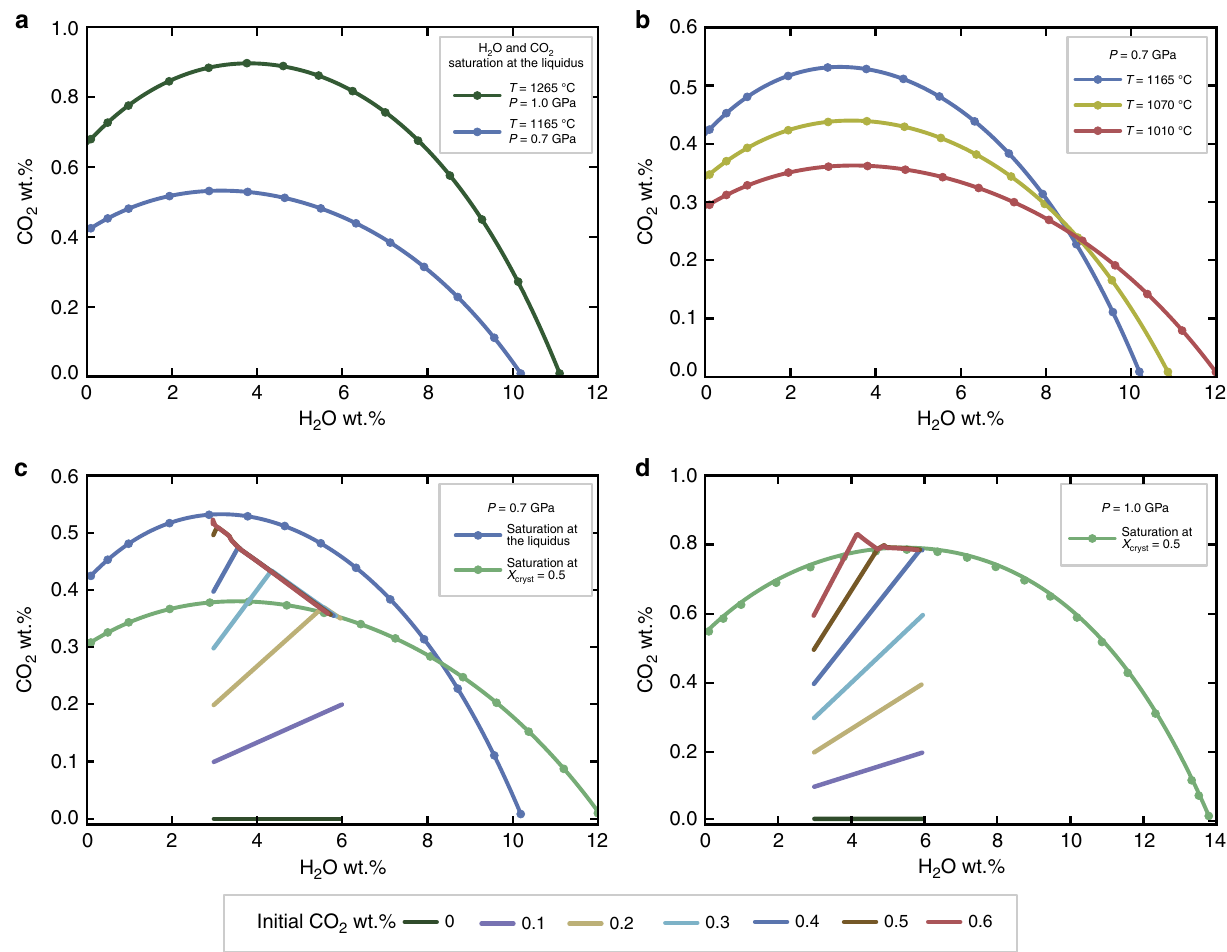
Fig. 1 Water and carbon dioxide solubilities in the melt phase. Solubility curves for water and carbon dioxide calculated for the mid-MgO system 30 : a Solubilities of the parental melt at pressures of 0.7 and 1.0 GPa and liquidus temperatures; b Solubilities of the residual melt during the crystallization process at a pressure of 0.7 GPa. The SiO 2 content in the residual melt on dry basis is 50.3, 50.9, and 57.2 wt.% respectively; c Equilibrium thermodynamical models performed by rhyolite-MELTS 59 at 0.7 GPa displaying the evolution of H 2 O and CO 2 in the residual melt during the crystallization process; d Equilibrium thermodynamical models performed by rhyolite-MELTS 59 at 1.0 GPa displaying the evolution of H 2 O and CO 2 in the residual melt during the crystallization process. The parameter X cryst reported in c , d is the crystal mass